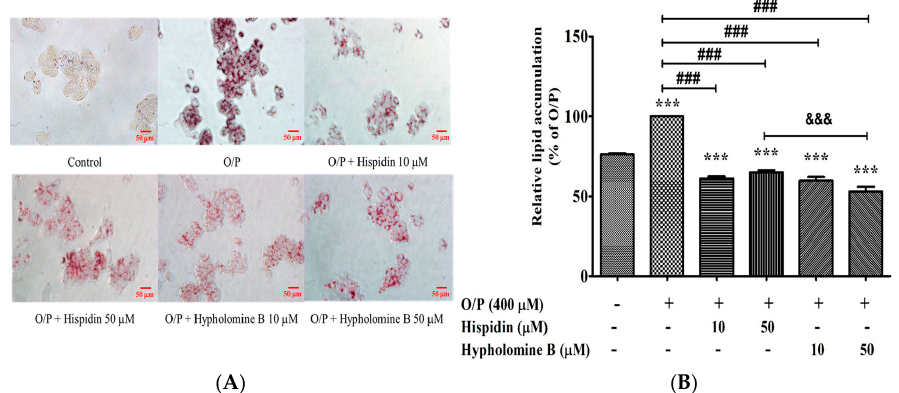
Figure 8. Effects of purified compounds from PL-EA on Oil Red O staining and lipid. accumulation in HepG2 cells. Lipid droplets in HepG2 cells were photographed by phase contrast microscopy (original magnification ×200) ( A ). The lipid content from Oil Red O stained cells was quantified by spectrophotometric analysis at 500 nm ( B ). Bars represent mean ± SE ( n = 3) *** p < 0.001 vs. the control ; ### p < 0.001 vs. the O/P group; &&& p < 0.001. Significant differences between groups were determined using one-way ANOVA followed by Tukey’s procedure.